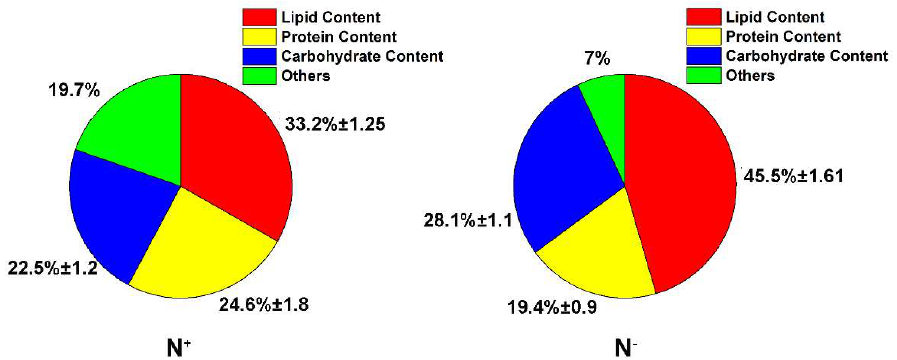
Figure 10. Comparison of biochemical composition (Lipid, Carbohydrate and Protein) of Parachlorella kessleri TY02 under N + and N − culture media on the 7th day. Data are shown as mean ± SE. n = 3.